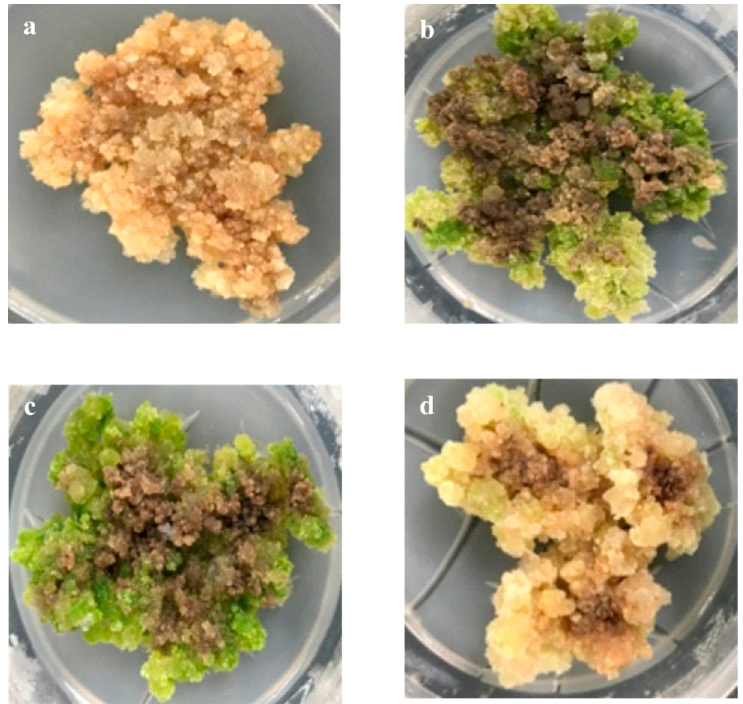
Figure 1. Gynura procumbens callus after 30-day culture under different Light-Emitting Diode (LED) lights. ( a ) Dark, ( b ) Blue, ( c ) White, and ( d ) Red.